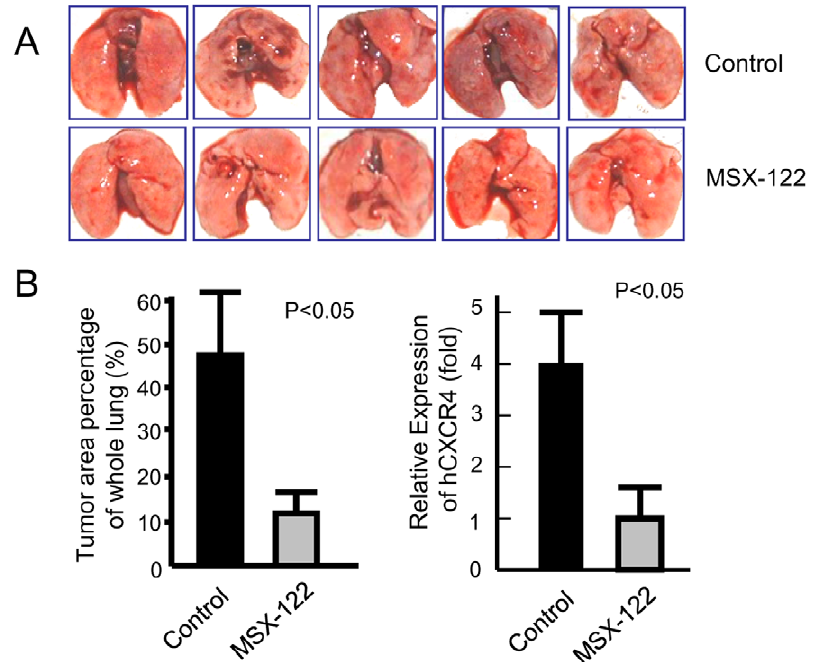
Figure 6. MSX-122 blocks metastasis in an experimental animal model of breast cancer metastasis. (A) Representative photographs of 5 lungs were shown from each group. (B) Histological quantization shows a decrease in tumor area in the treated group. Quantitative real-time RT-PCR of human CXCR4 confirms that animals injected with MDA-MB-231 cells and treated with vehicle develop lung metastasis. On the other hand, animals injected with MDA-MB-231 cells and treated with MSX-122 (4 mg/kg, i.p., daily) develop significantly less metastasis.